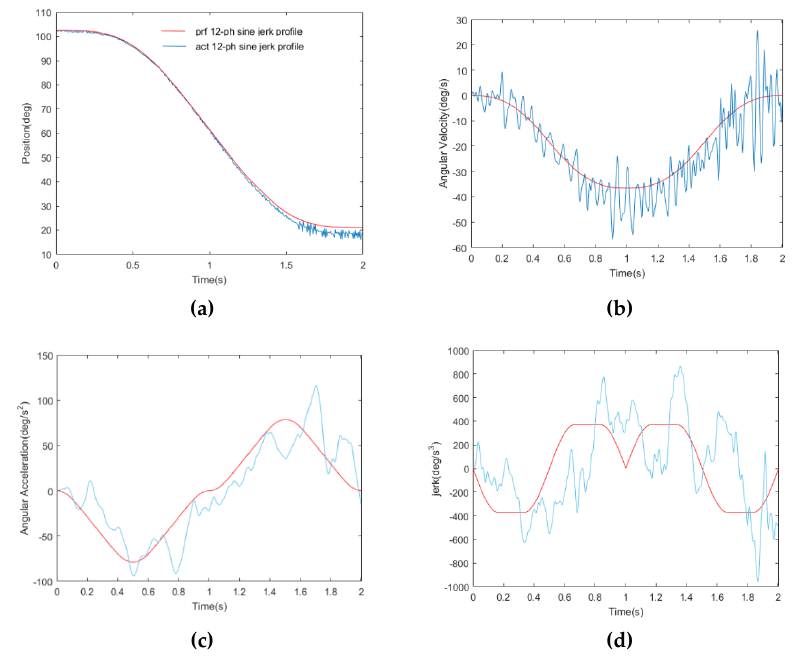
Figure 7. Simulation and experimental comparison curves of 12 − phase sine jerk motion profile key characteristic in Joint 1: ( a ) angular displacement curve, ( b ) angular velocity curve, ( c ) angular acceleration curve, and ( d ) angular acceleration rate.